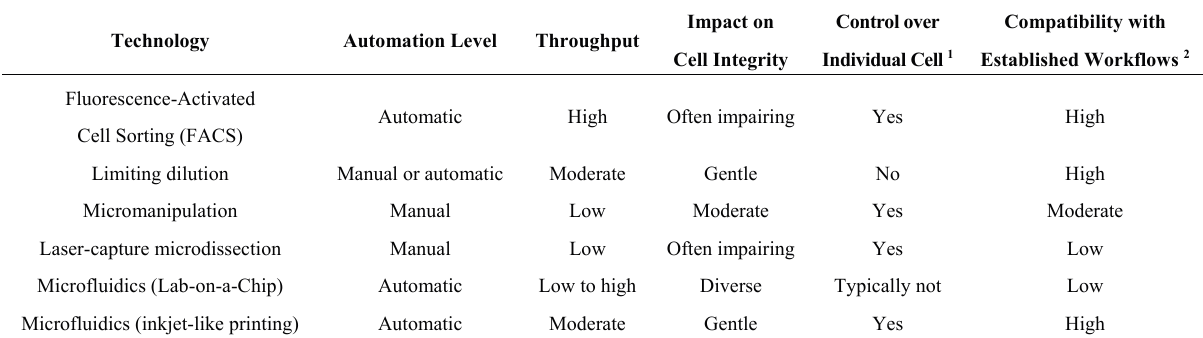
Table 3. Selected features of discussed technologies. Rating based on the authors’ personal experience and knowledge.